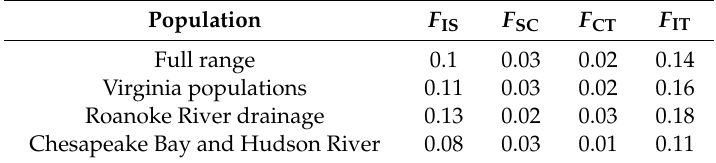
Table 5. F -statistics partitioning departure from Hardy-Weinberg equilibrium for stated groups of populations. Population F IS F SC F CT F